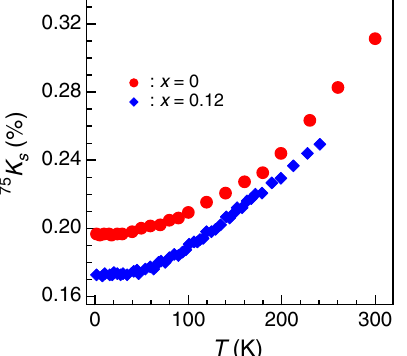
FIG. 11. The Knight shifts of LiFe 1 − x Co x As for the x ¼ 0 and x ¼ 0 . 12 samples. The Knight shift for both samples is measured with the external field perpendicular to the a - b plane to avoid calculation of the second-order quadruple correction. Though the size of the Knight shift along different directions may be different, they share the same temperature dependence. There- fore, we are able to take the K s at H ∥ c to estimate the behavior of H ∥ ab